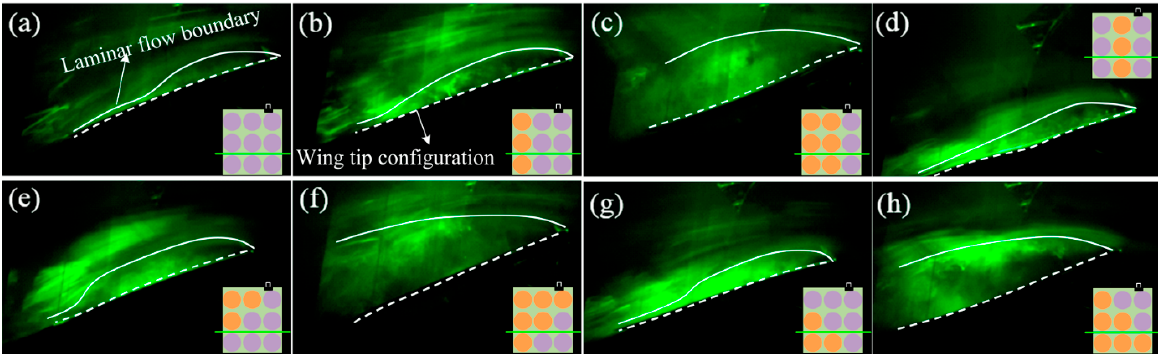
Figure 4. Smoke-wire flow visualization results of the test wing with eight configurations ( a – h ) (Re = 100,000, α b = 20 degree based on the connector). The green line in every inset indicates the plane for smoke-wire flow visualization.